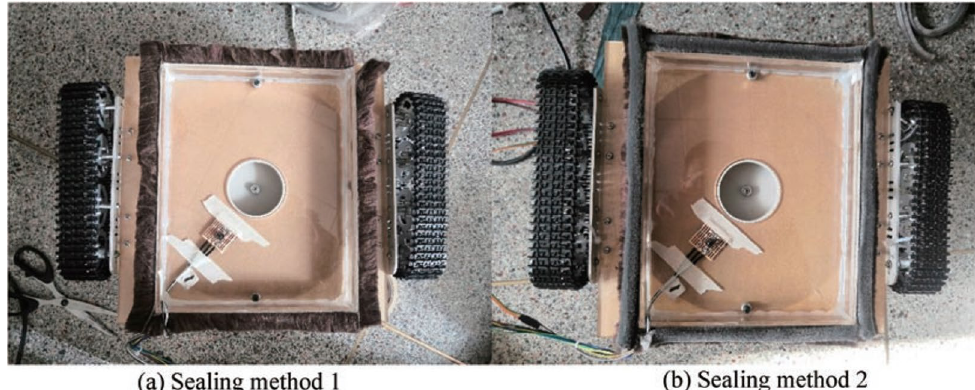
Figure 11. Two sealing methods.